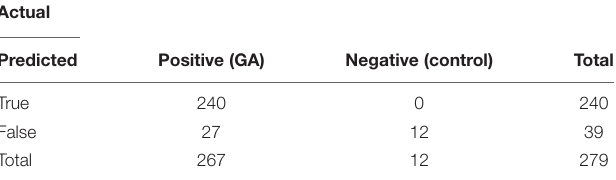
TABLE 3 | Performance of cancer-related